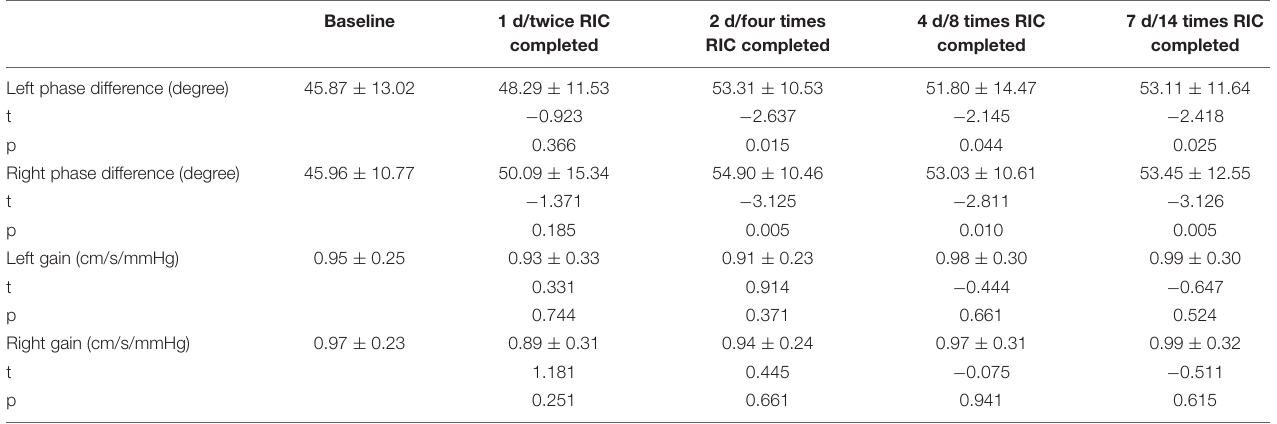
TABLE 3 | DCA parameters in participants during